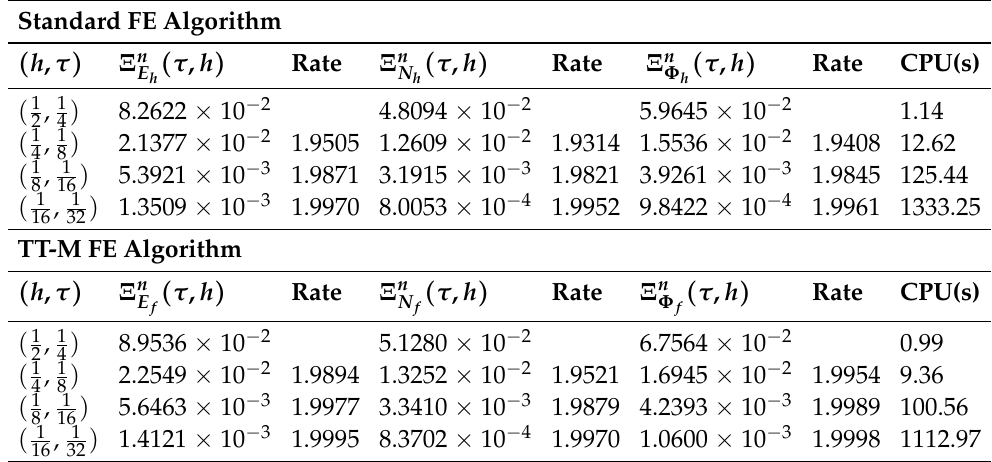
h and τ C = 4 τ 2